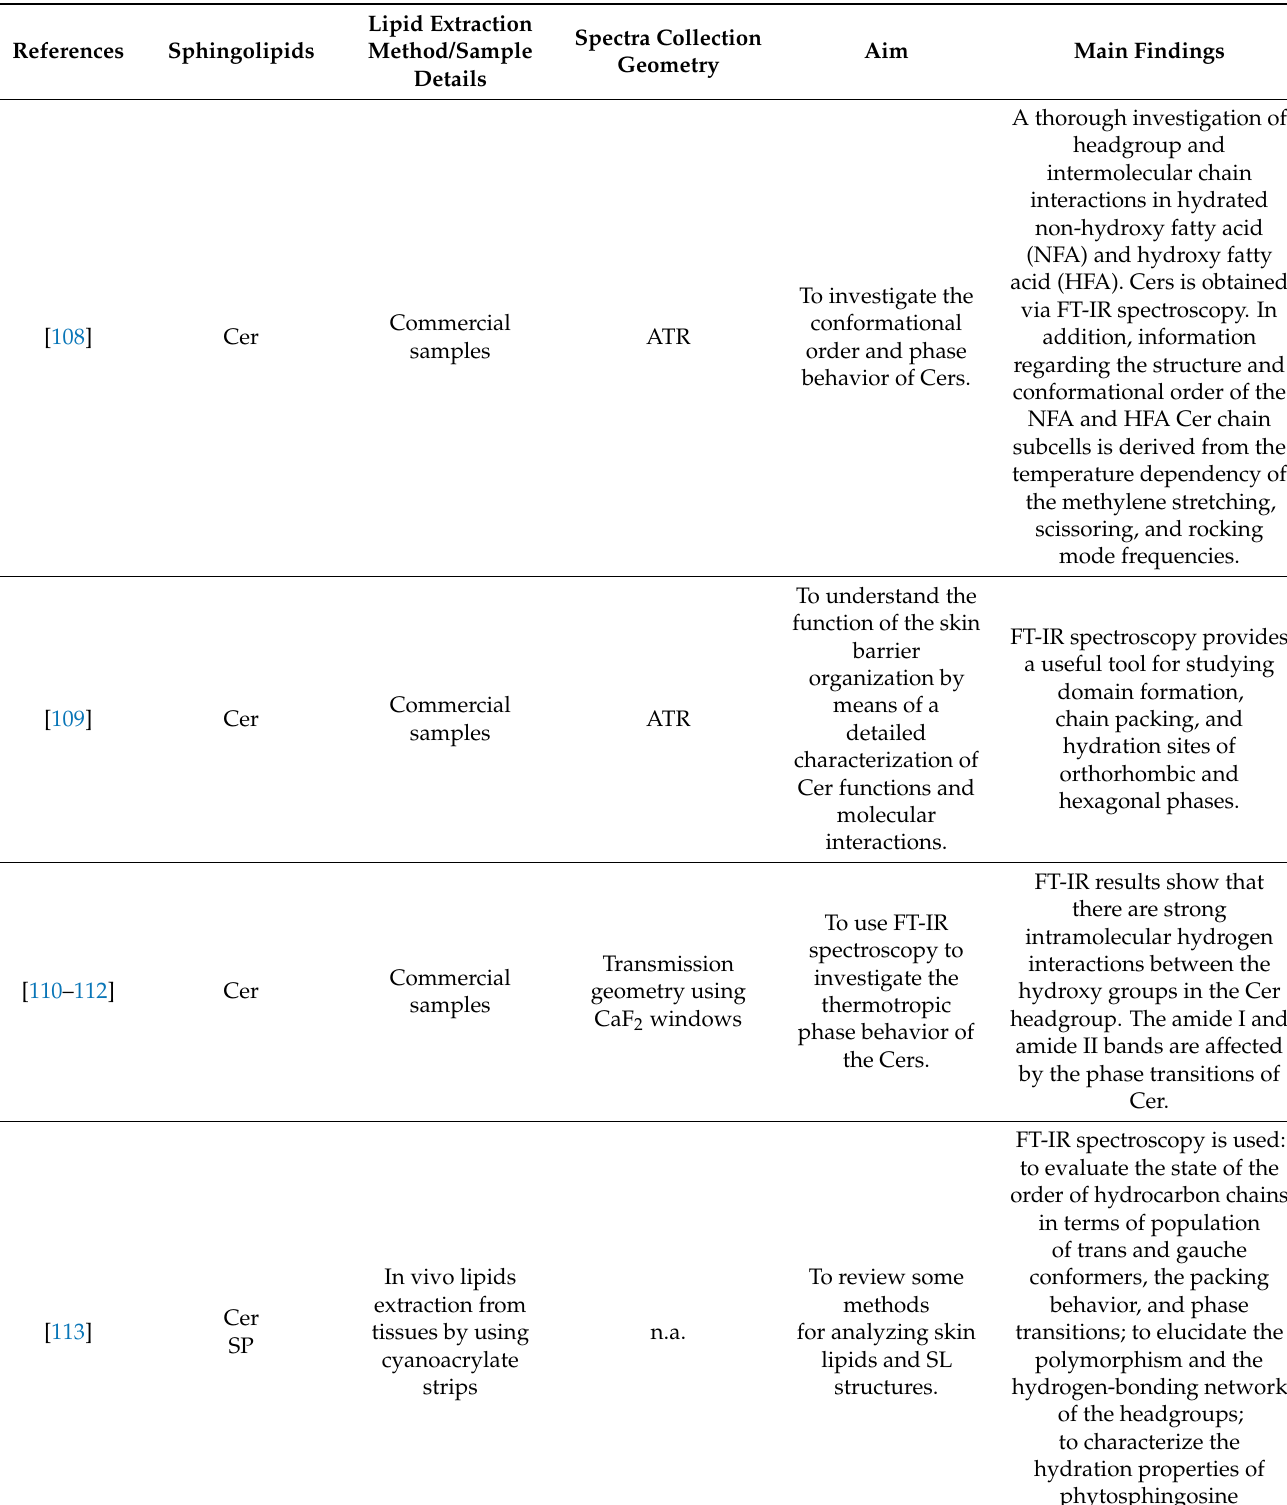
Table 5. Summary of some relevant results obtained on Cer, Cer-SP, and Cer-SM by using different FT-IR spectroscopy